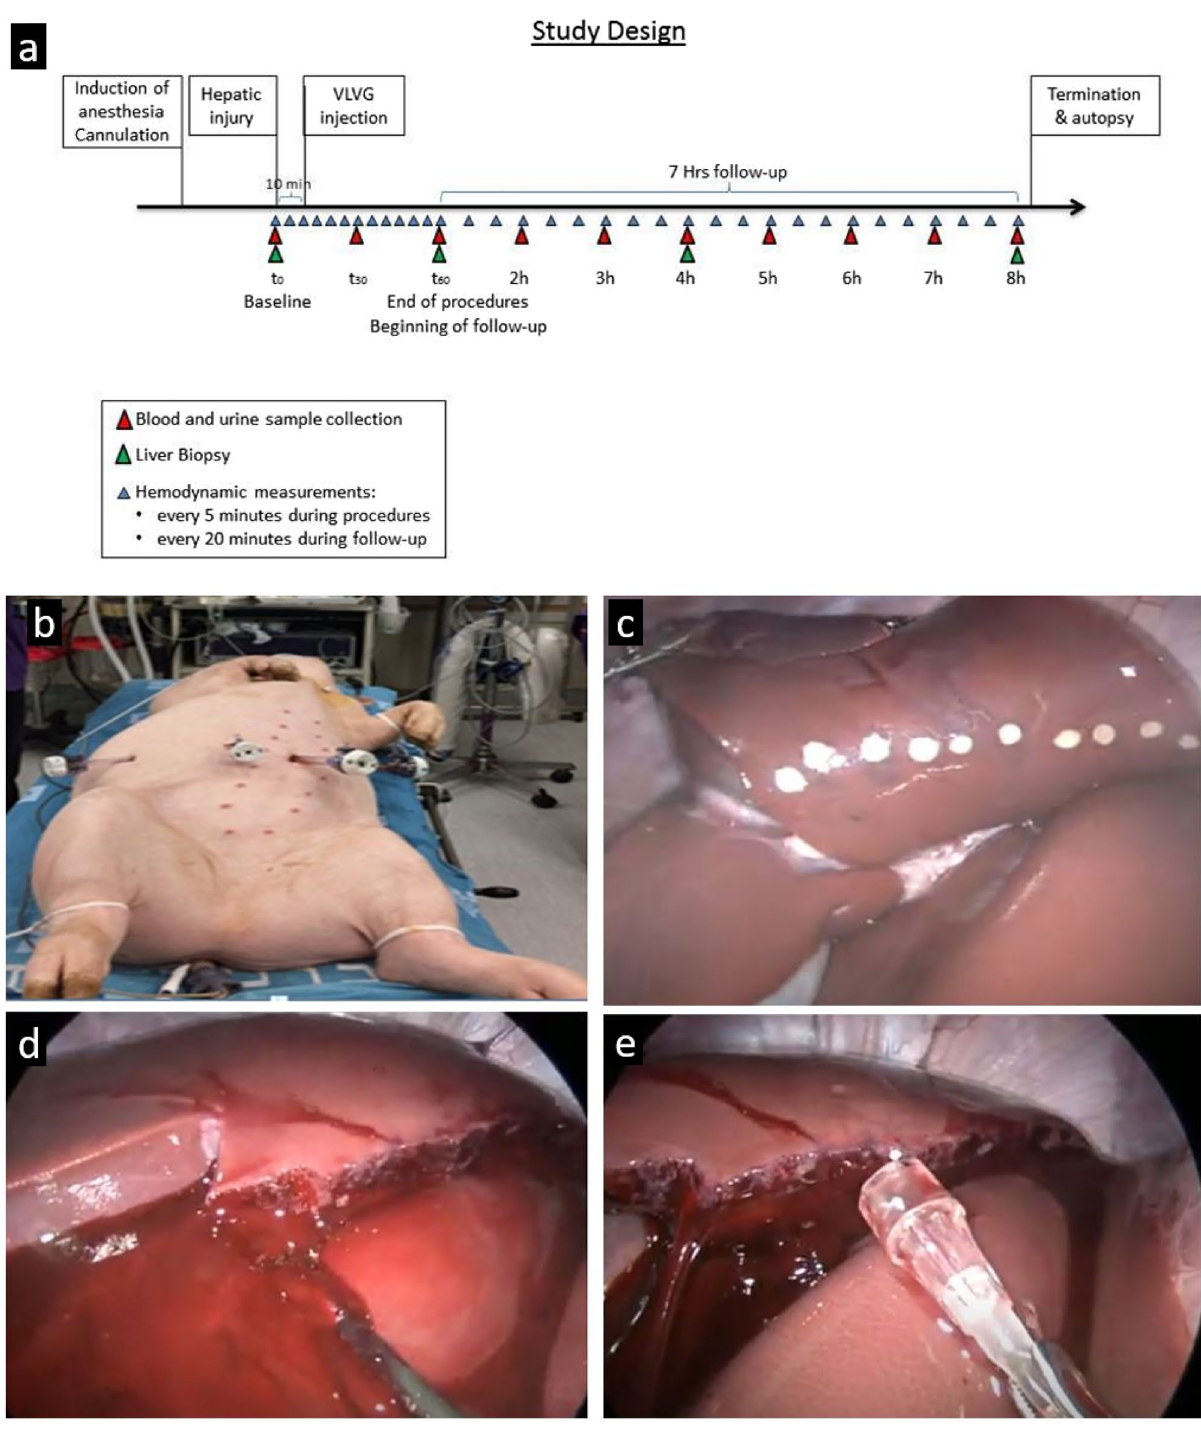
Figure 4. Study design and induction of liver injury. ( a ) a scheme of the study design; ( b ) pneumoperitoneum was induced using a Veress needle, and three trocars were introduced to perform laparoscopy; ( c-e ) marking the edge of the liver lobe, 4 cm from the portal vein, followed by a left